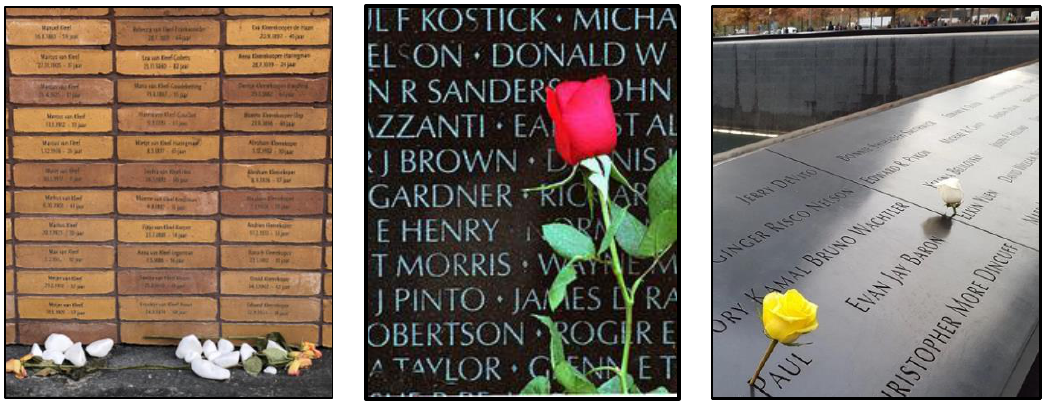
Figure 6. Individual names at the Holocaust Names Memorial ( left ), Vietnam Veterans Memorial ( center ), and 9/11 Memorial ( right ).